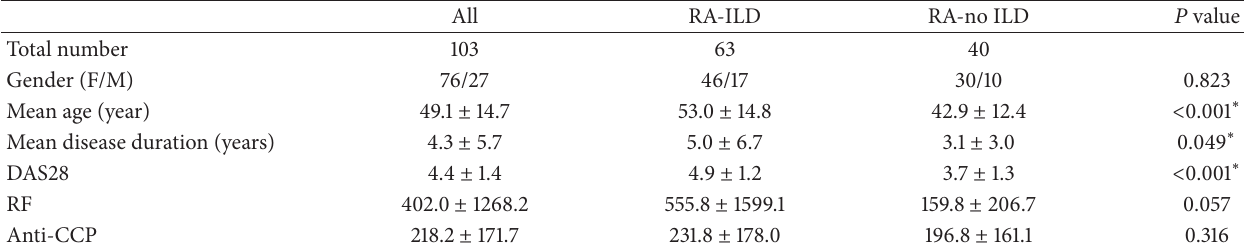
Table 1: Comparison of clinical characteristics in RA-ILD and RA-no ILD.